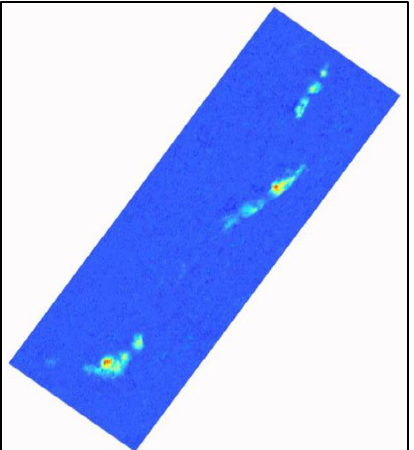
Figure 4. Deformation rate from 2015 to